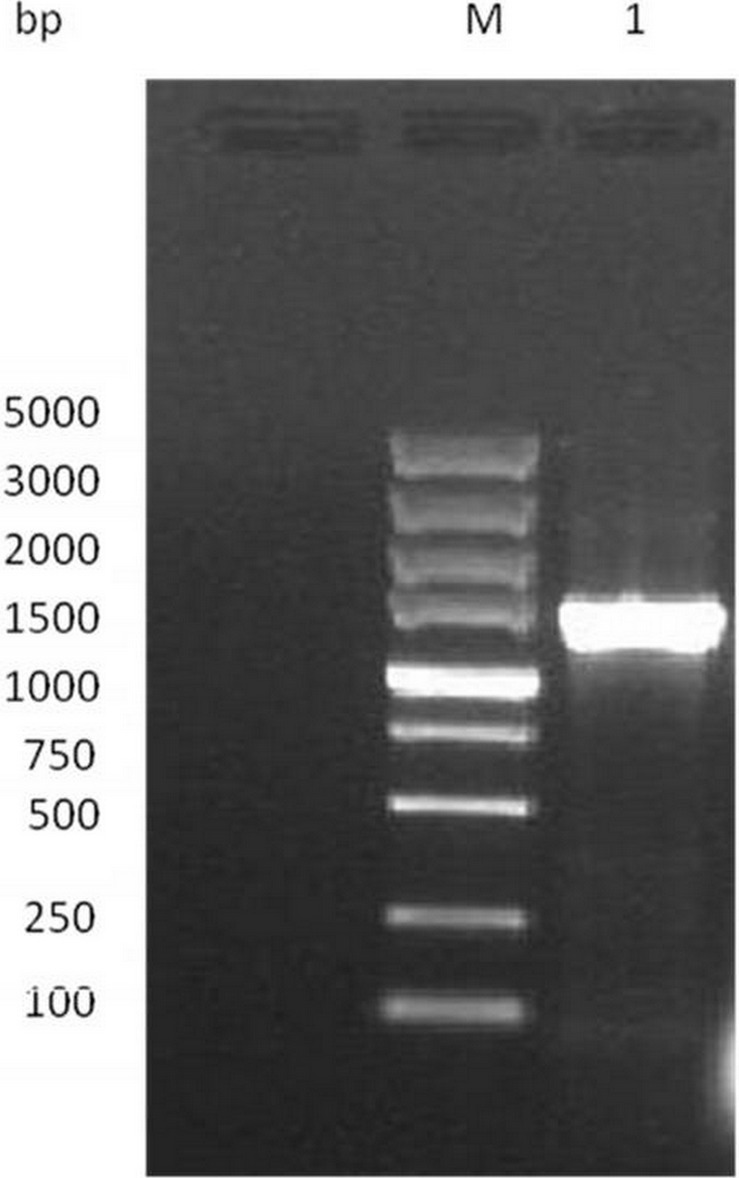
Electrophoresis analysis of GAD gene.Lane M, DL 2000 DNA Marker; lane 1, GAD gene of the strain.